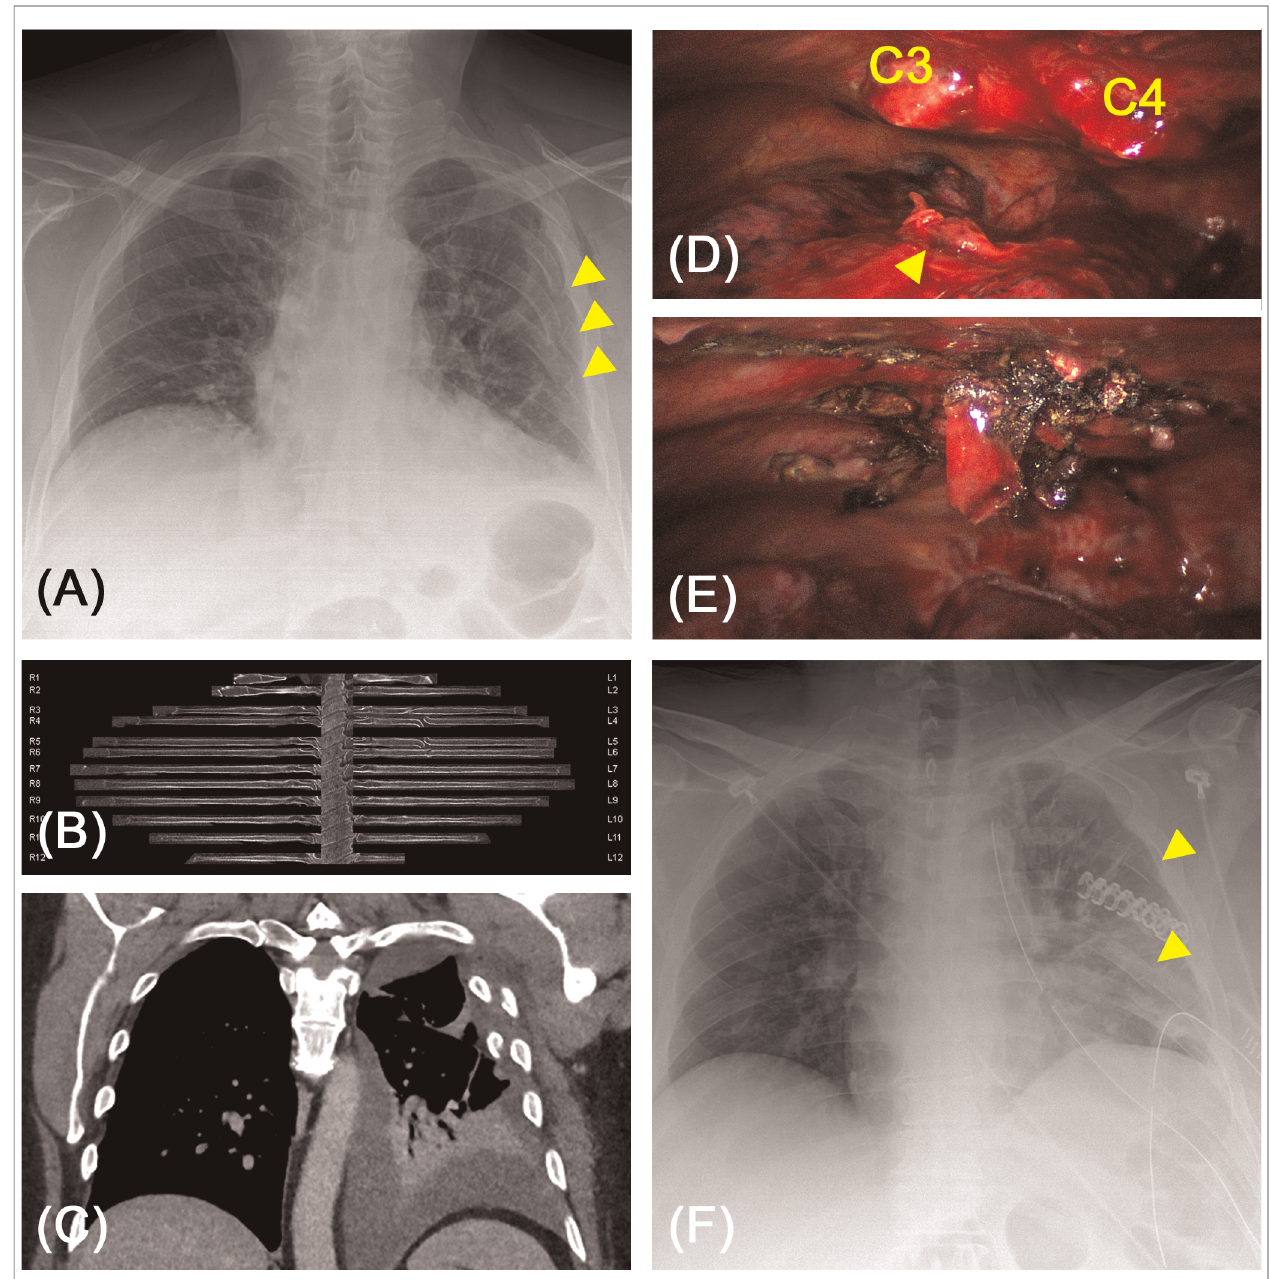
videoscopy showed dislocated fracture endings of costae 3 and 4 subscapular causing an actively bleeding laceration of the lung parenchyma (arrow). After osteosynthesis of costa 4 the lateral chest wall was suf fi ciently erected and palpatory stable. ( F ) Post-operative chest X-ray after rib stabilization, reconstruction of lung parenchyma and relieve of 800 mL hemothorax. By a single stabilization the adjacent ribs were also repositioned